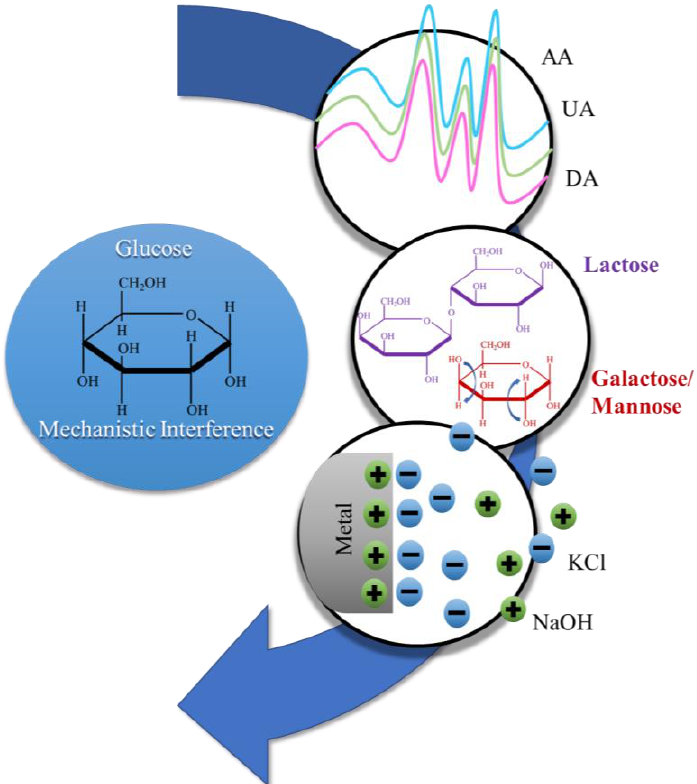
Figure 5. Graphic representation of the mechanistic interference of interfering compounds that have similar electrochemical peaks (AA, UA, and DA), chemical structure (lactose, mannose, and galactose), or surface electrocatalytic effects (KCl and NaOH) with the glucose sensor by Ye et al. [91].